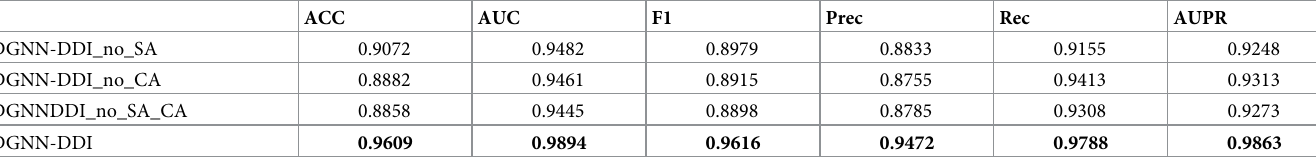
Table 2. Investigating the contributions of substructure-attention mechanism and co-attention layer.